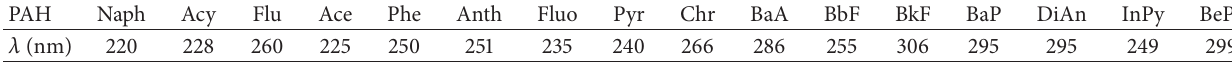
Table 2: Specific wavelengths of the 16 PAHs studied.